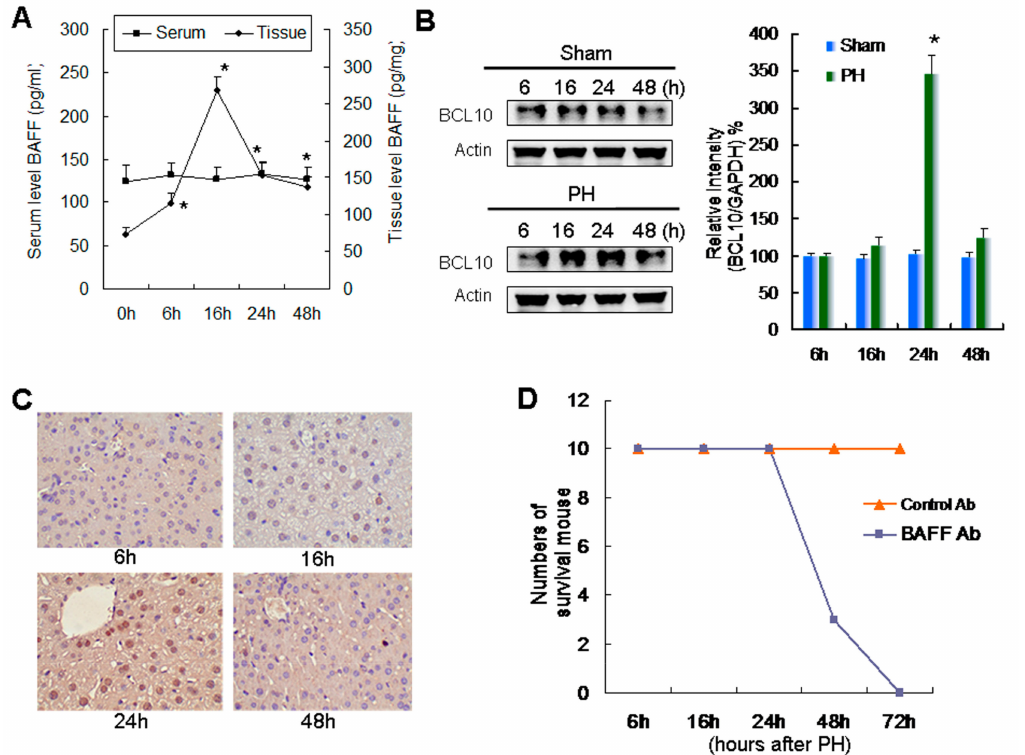
Figure 1. B-cell activating factor (BAFF) and B-cell CCL / lymphoma 10 (BCL10) expression in 70% partial hepatectomy-induced liver regeneration in mice. ( A ) Serum and tissue levels of BAFF